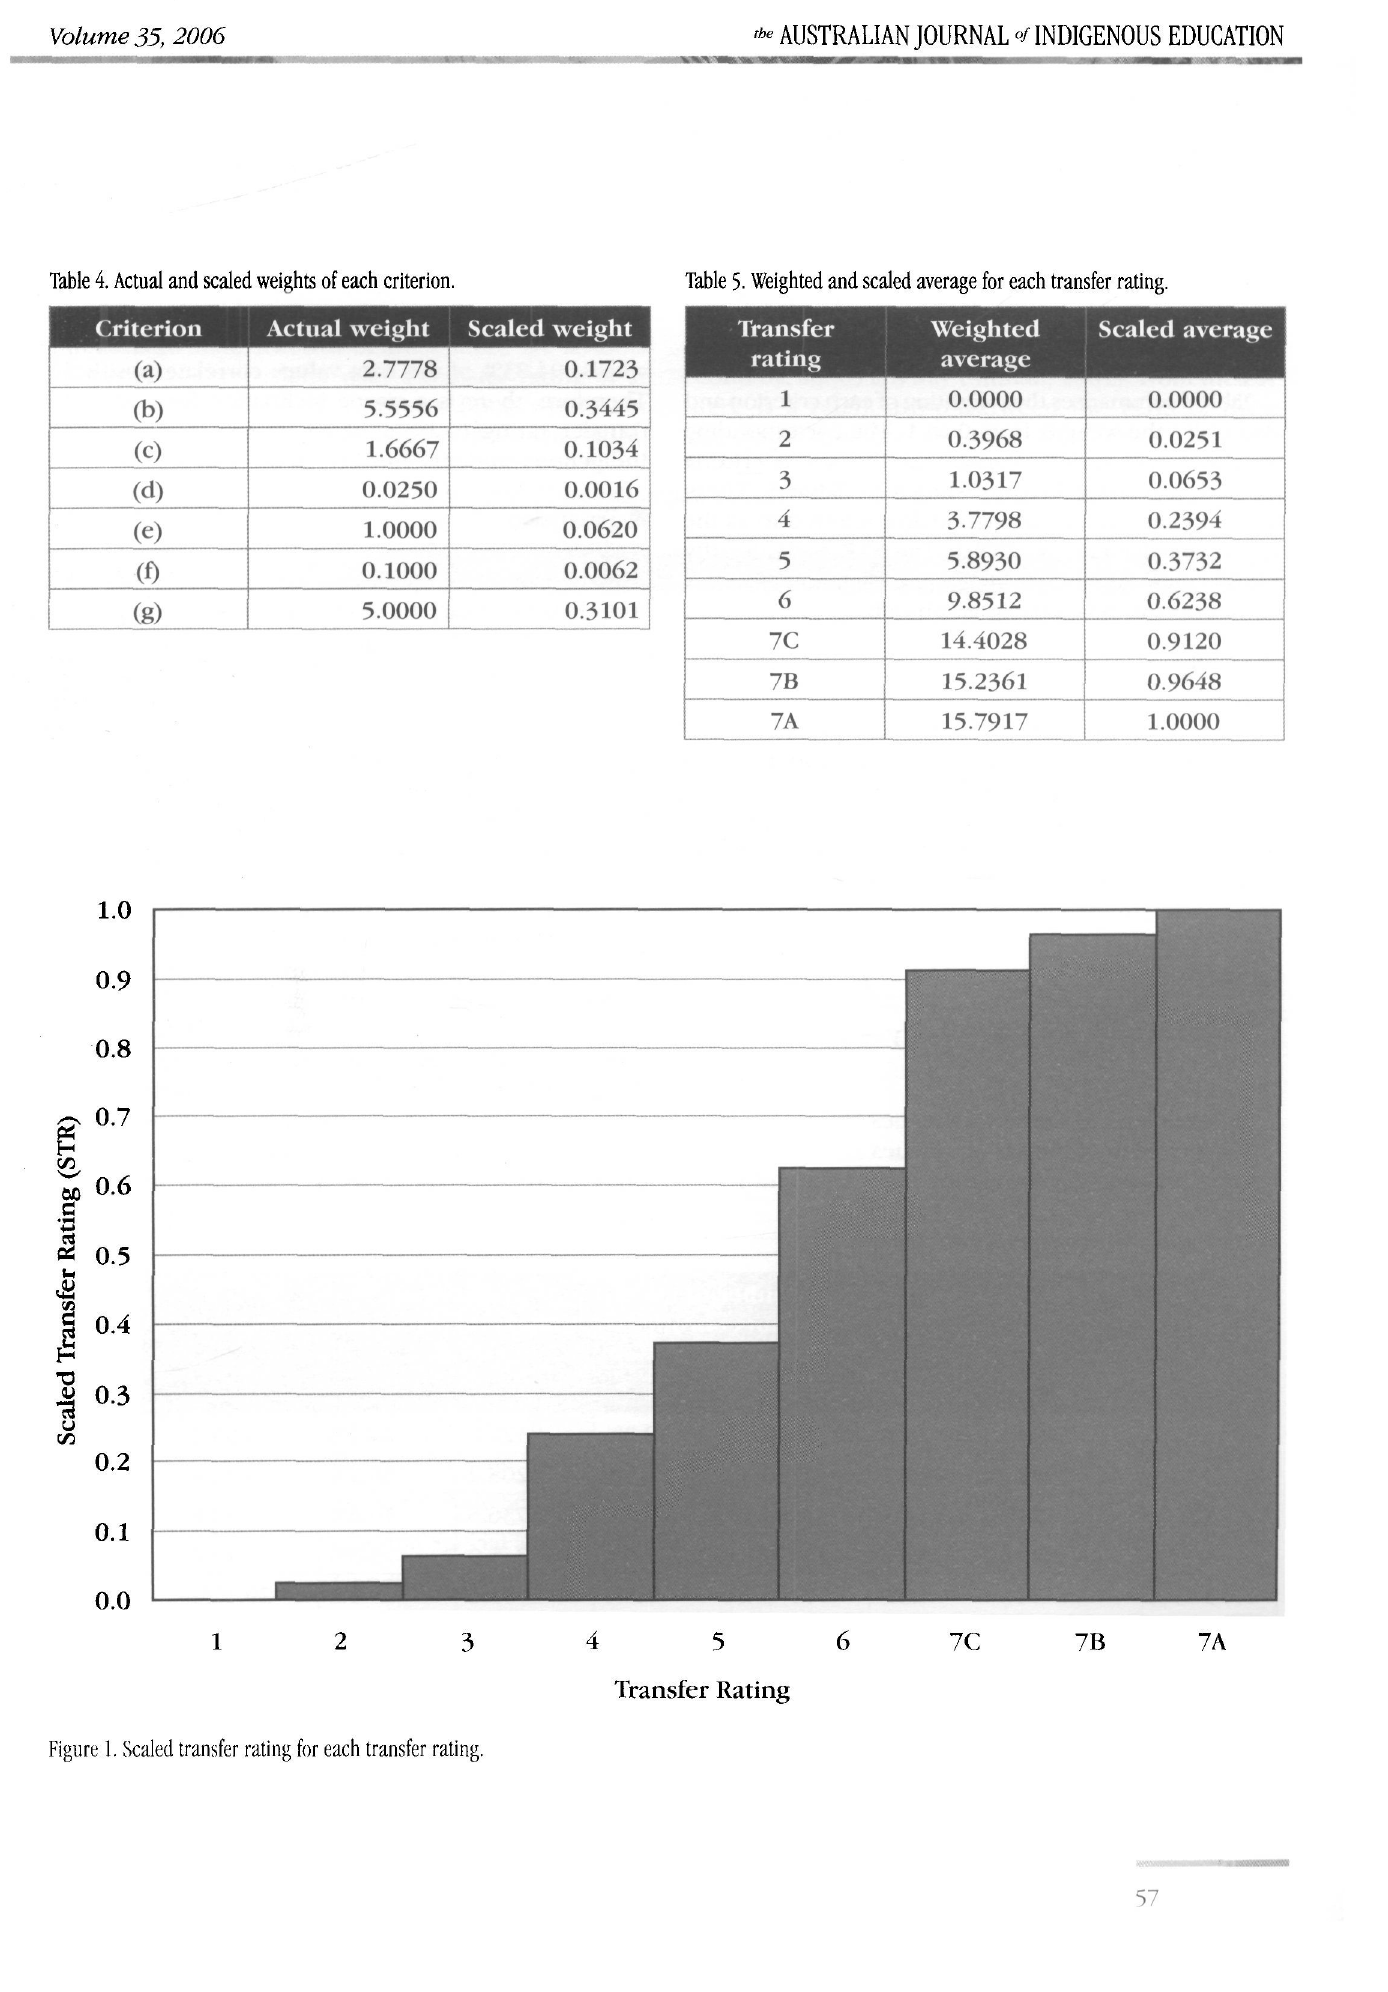
Figure 1. Scaled transfer rating for each transfer